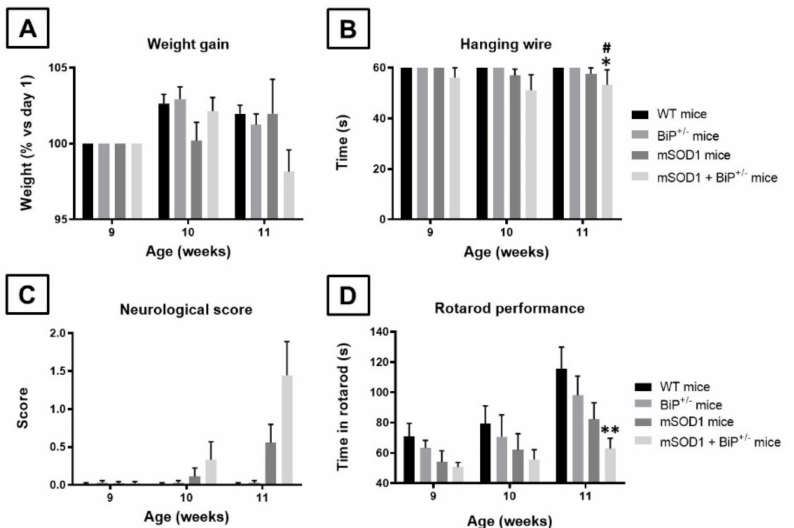
Figure 1. Weight gain (panel ( A )), hanging wire response (panel ( B )), neurological score (panel ( C )), and rotarod performance (panel ( D )) analyzed at the period of 9 to 11 weeks of age in mSOD1 transgenic and wild-type male mice with normal or partial ablation of the BiP protein. Values are means ± SEM of 6–10 animals per group. Data were assessed by two-way analysis of variance (with repeated measures) followed by the Tukey test (* p < 0.05, ** p < 0.01 vs. WT mice; # p < 0.05 vs. BiP +/ −